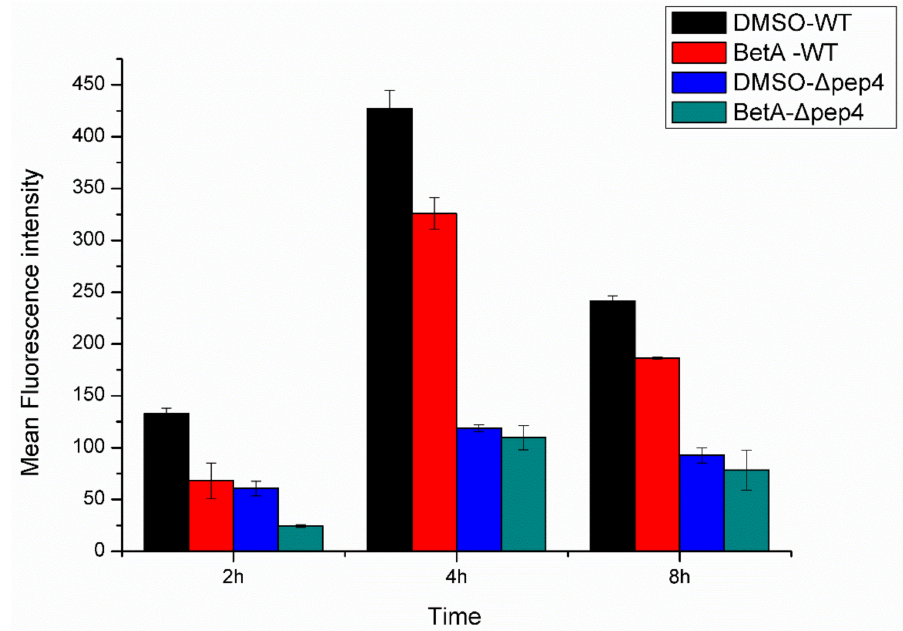
Figure 7. The change of S. cerevisiae mitochondrial membrane potential for four experimental groups. 1 × 10 7 CFU / mL cells were incubated with 20 µ g / mL BetA for 2 h, 4 h, and 8 h, respectively. Thereafter, yeast cells were stained with Rhodamine-123 (10 µ M) for 30 min and then analyzed in FL-1 channels of flow